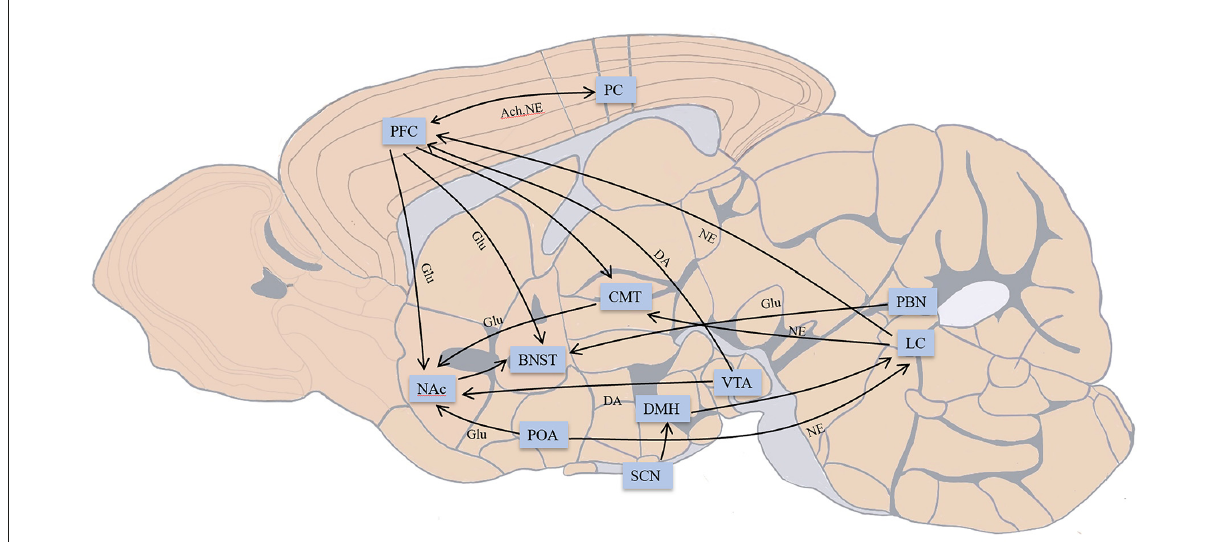
FIGURE1 Main connections in brain areas related to conscious changes during sevoflurane anesthesia; not all connections are shown. The connection between the prefrontal cortex (PFC) and parietal cortex (PC) participates in fronto-parietal network. PFC provides descending projections to bed nucleus of stria terminalis (BNST), nucleus accumbens (NAc), centromedial nucleus of the thalamus (CMT), and receives inputs from the ventral tegmental area (VTA), locus coeruleus (LC). CMT receives input from LC, and PFC and outputs to NAc. The preoptic area (POA) connects with LC and projects to NAc. Indirect projections from the suprachiasmatic nucleus (SCN)-dorsomedial hypothalamic nucleus (DMH)-LC function as an arousal system in the brain. VTA provides dopaminergic projections to NAc. LC outputs noradrenergic projections over the whole brain. BNST receives glutamatergic input from the parabrachial nucleus (PBN). NAc projects to BNST may participate in the consciousness changes during sevoflurane anesthesia. Excitatory neurotransmitters: Glu, glutamate; DA, dopamine; NE, norepinephrine; Ach, acetylcholine. Inhibitory neurotransmitters: GABA, γ -aminobutyric